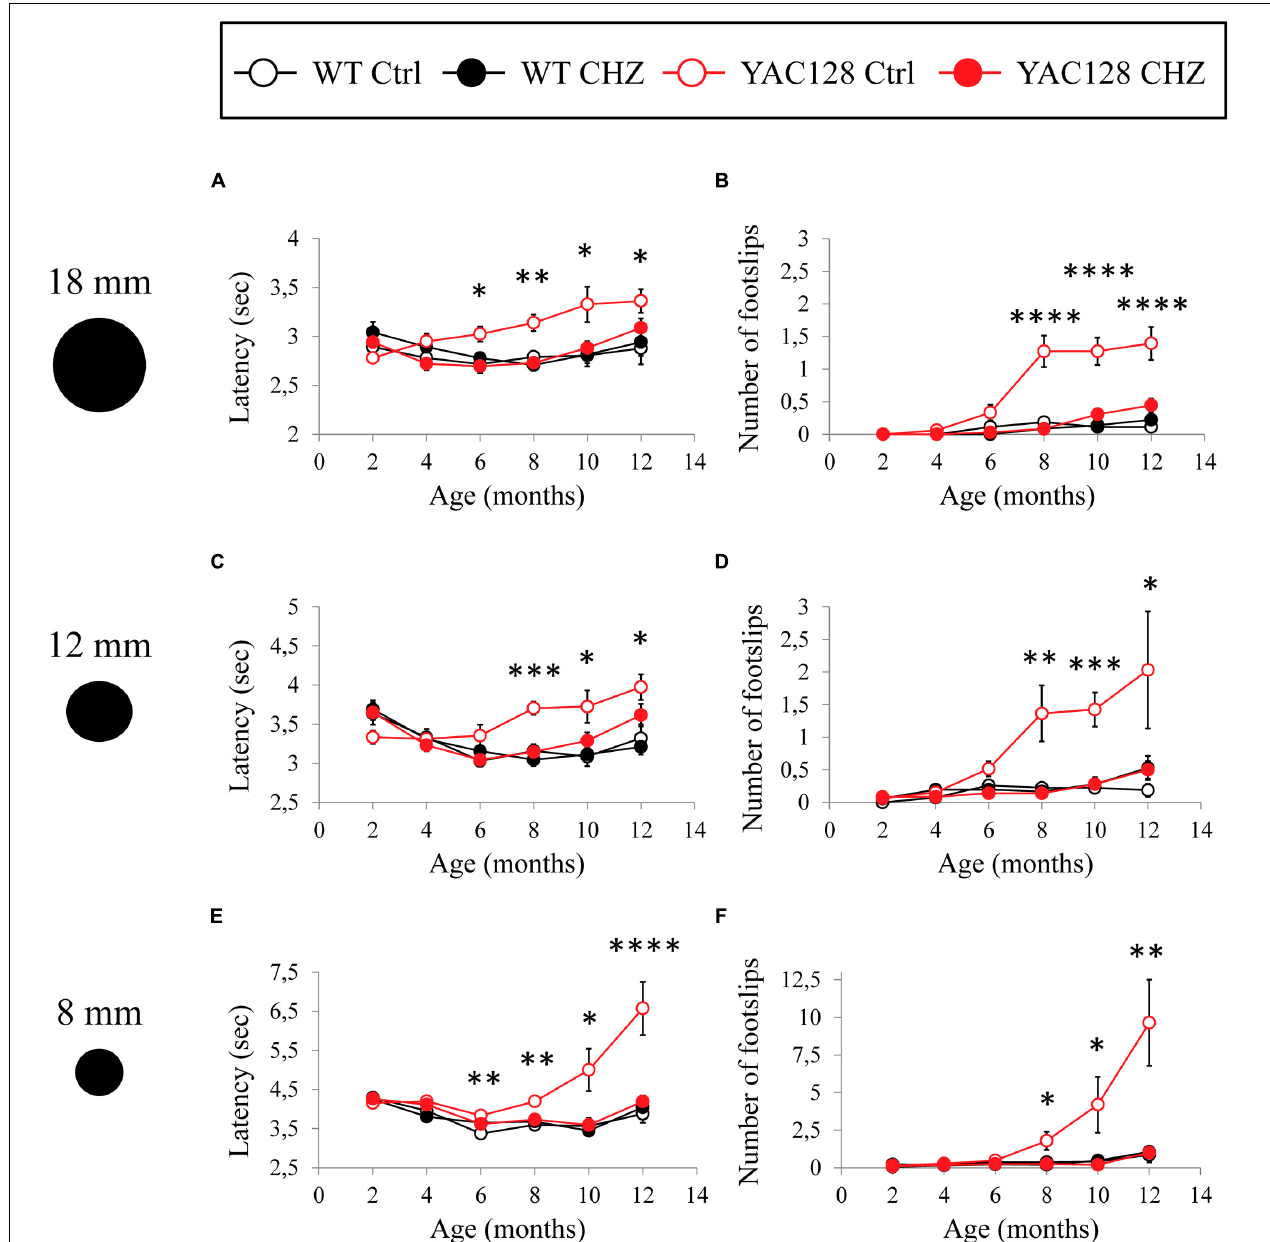
FIGURE 6 | CHZ treatment improves performance of YAC128 mice in the beam-walk test. The average mean latency as the mice traverse the 1 m length of the 18 mm (A) , 12 mm (C) , and 8 mm (E) beam is plotted for the 2, 4, 6, 8, 10, and 12-month-old WT and YAC128 mice in control and CHZ treatment groups as mean ± SE. Average number of foot slips as the mice traverse the 1 m length of the 18 mm (B) , 12 mm (D) , and 8 mm (F) beam is plotted for the 2, 4, 6, 8, 10, and 12-month-old WT and YAC128 mice as mean ± SE. * p < 0.05; ** p < 0.01; *** p < 0.001; **** p < 0.0001 significant differences between control WT group and control YAC128